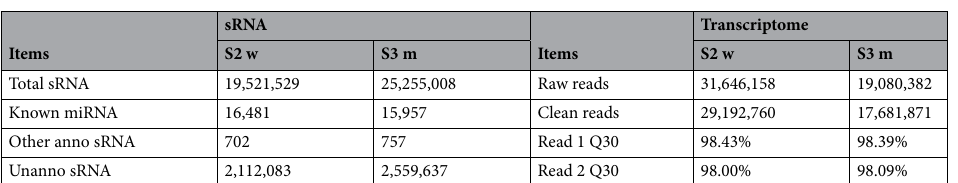
Table 1. Statistics of the sequencing data. Known miRNA: The sRNAs annotated by plant miRBase database. Other anno sRNA: annotated sRNAs other than rRNA, tRNA, sRNA, snRNA and miRNA. Unanno sRNA: unannotated sRNAs. Raw Reads: The number of sequencing sequences of each document is counted in four action units by counting the original sequence data. Clean reads: The calculation method was the same as Raw Reads, but the statistical files were filtered data, and subsequent analysis was based on this. Q20, Q30: The percentages of bases with phred value greater than 20 and 30 in the total bases were calculated